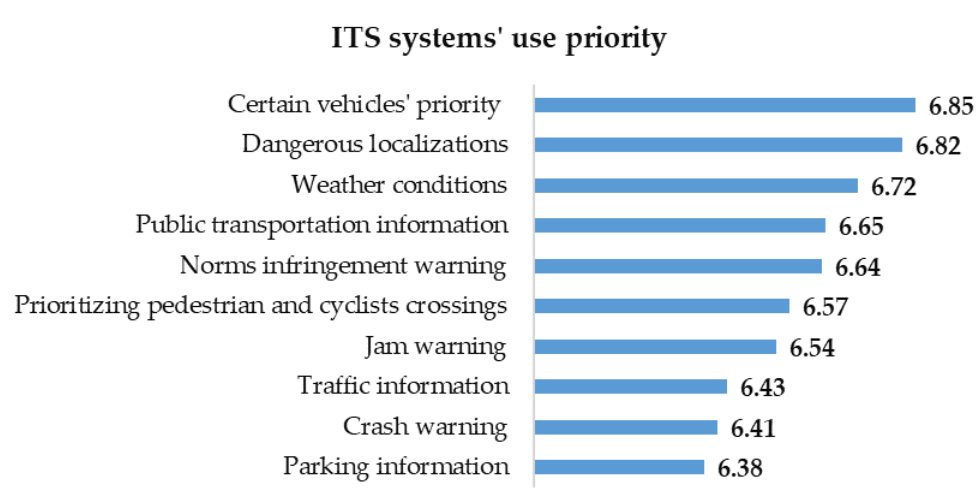
Figure 1. Priority of the use of intelligent transportation systems (ITS) according to Dominican citizens.